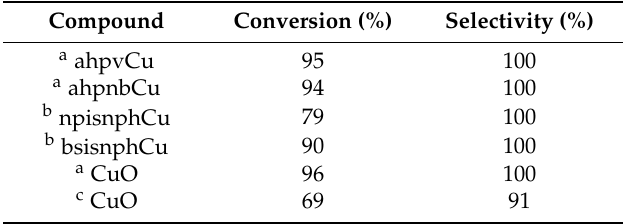
Table 2. Comparison of the catalytic activity for BzOH oxidation using Schiff-base complexes and metal oxides.